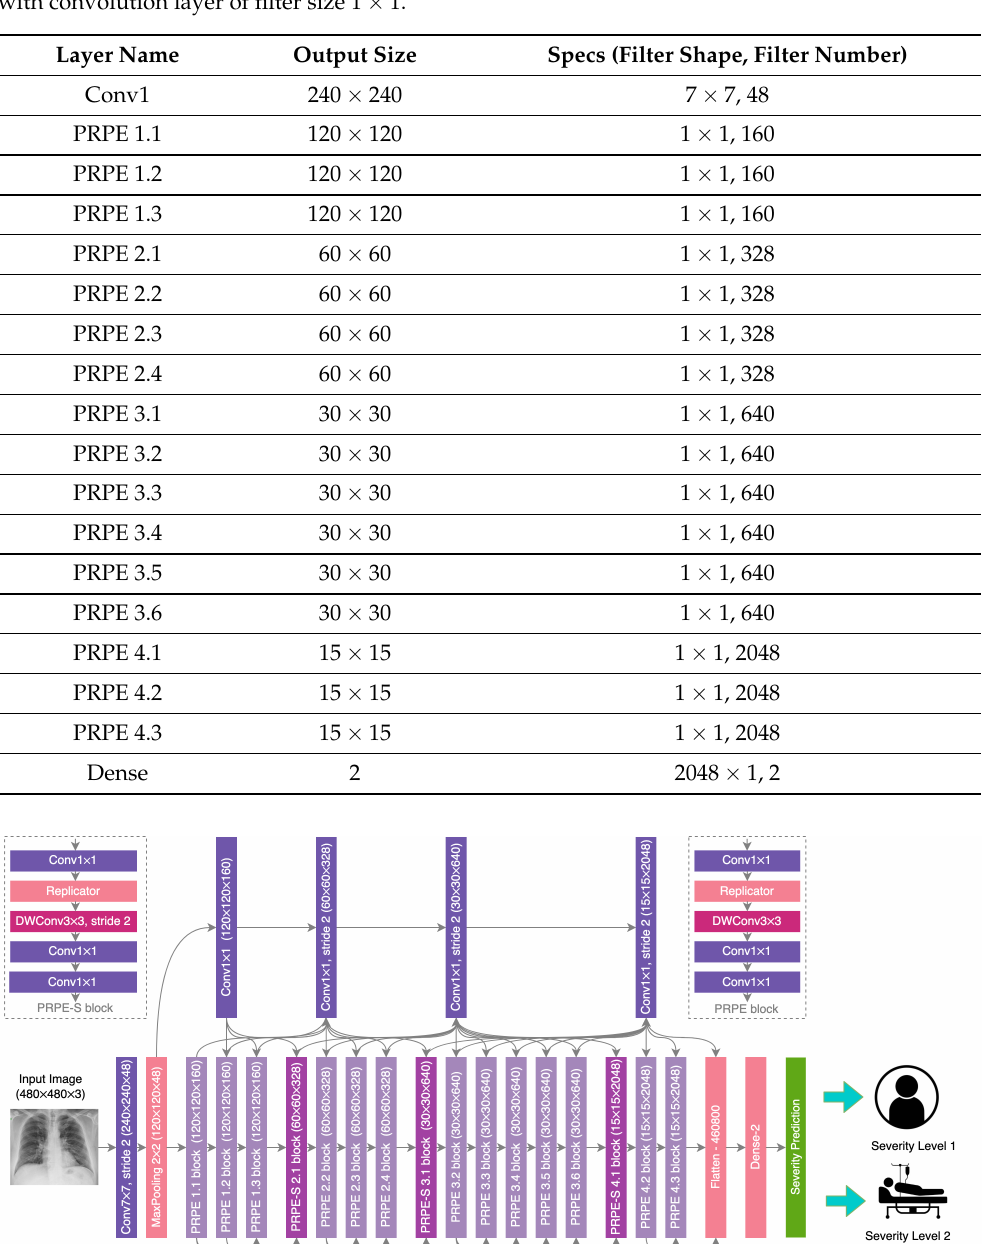
Figure 1. COVID-Net CXR-S network design. The COVID-Net backbone design exhibits high archi- tectural diversity and sparse long-range connectivity, with macroarchitecture and microarchitecture designs tailored specifically for the detection of COVID-19 from chest X-ray images. The network de- sign leverages light-weight design patterns in the form of projection-expansion-projection-expansion (PEPE) patterns to provide enhanced representational capabilities while maintaining low architectural and computational